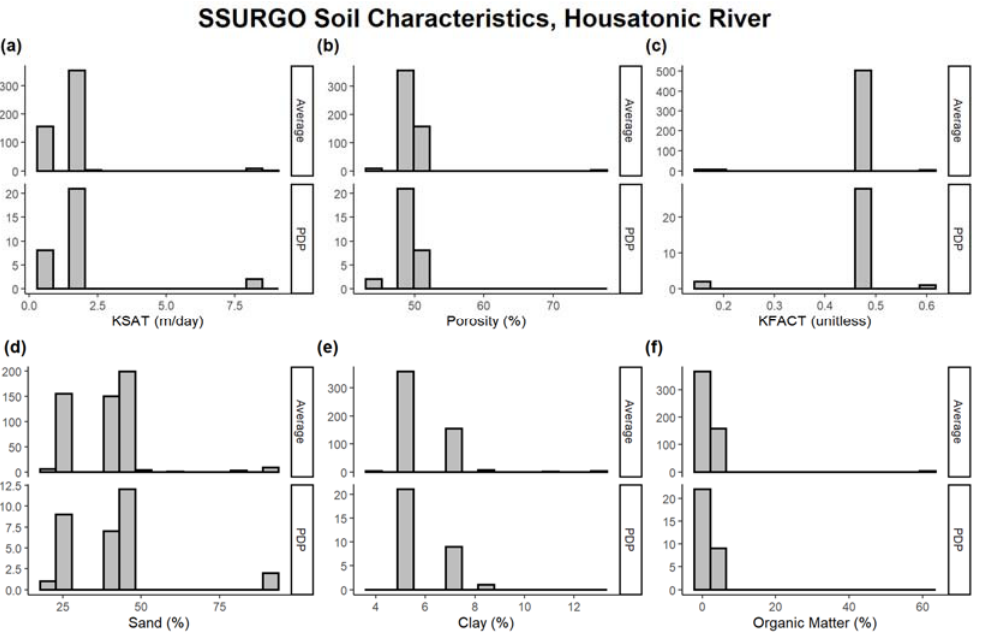
Figure 6. Soil parameters extracted from the SSURGO dataset at PDP locations and the average bank soil parameters from both banks of the Housatonic River reach for ( a ) KSAT, ( b ) porosity, ( c ) hydraulic conductivity factor (KFACT), ( d ) sand %, ( e ) clay %, and ( f ) organic matter %.